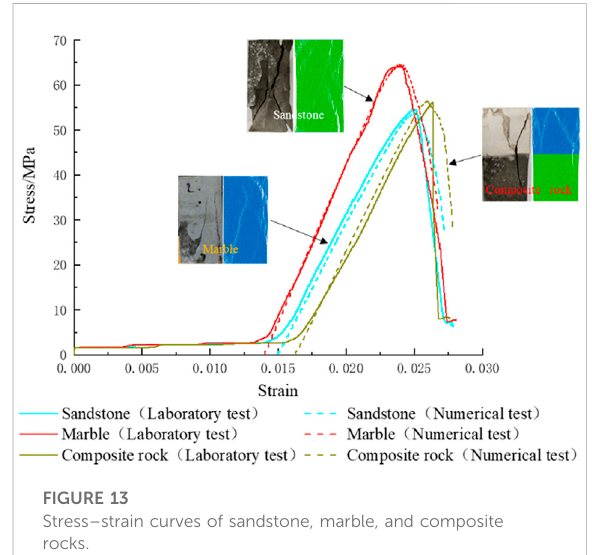
FIGURE 13 Stress – strain curves of sandstone, marble, and composite